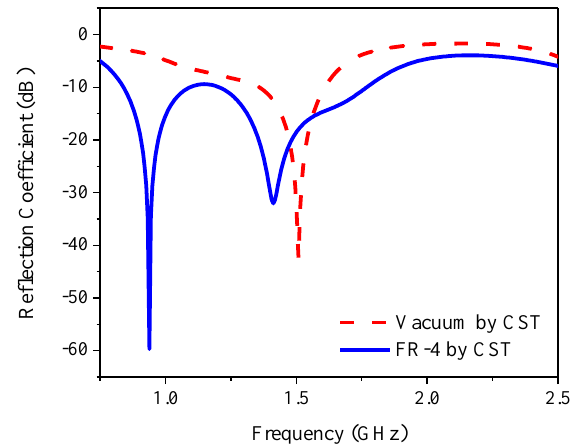
Figure 3. The reflection coefficient of the inverted L-shaped planar monopole antenna on a partial ground plane in vacuum and with FR-4 substrate.